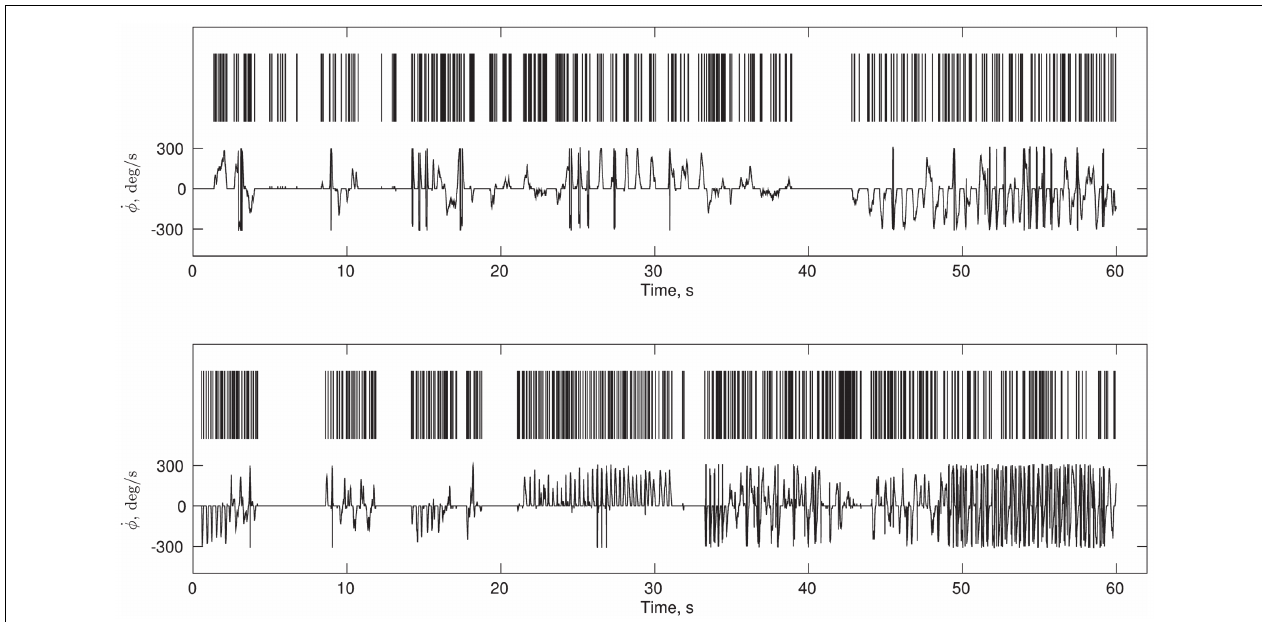
FIGURE 4 | Continuous and discrete representations motor activity. Two partners’ velocities from a sample trial are shown in the lower half of each panel. The upper series are the corresponding point processes obtained from the initial and terminal points of